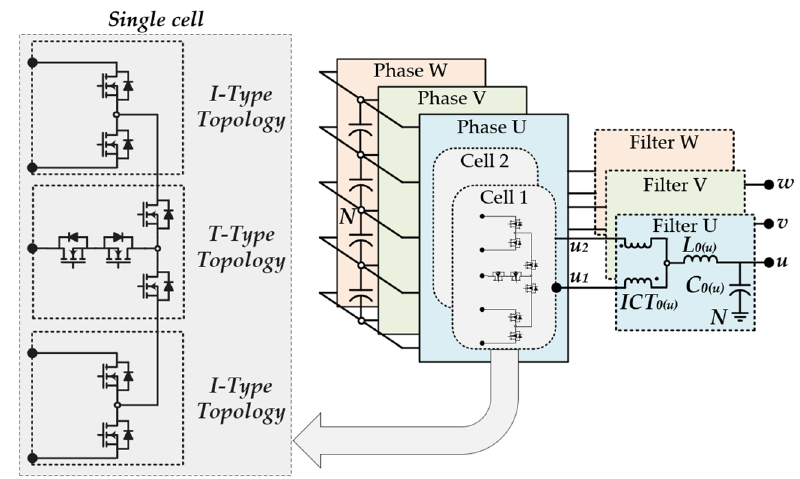
Figure 3 . Circuit of 3 Φ 5L E-Type Multilevel–Multicell Inverter (MMI).